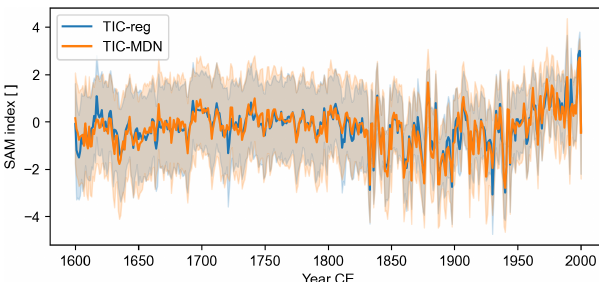
Figure 10. Z -scored (relative to 1901–2000CE) TIC-reg (in blue) and TIC-MDN (in orange) reconstructed SAM index over 1600– 2000CE (Table 1). The uncertainty (i.e., the ensemble spread; Sect. 2.1) associated with each reconstruction is represented by the shaded